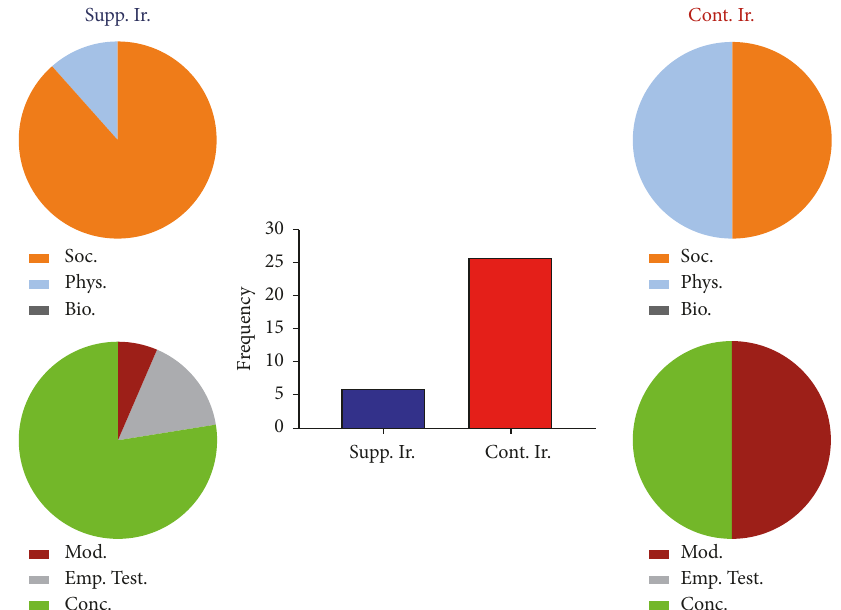
Figure 3: Visualising the frequency of quotes on the term irrationality that convey support for the theory versus those that challenge it. The pie charts on the left show the frequency of the supporting comments across the disciplines (on the top) and across the study types (in the bottom). Similarly, the pie charts on the right show the frequency of the contradicting comments again across the disciplines (on the top) and across the study types (in the bottom). The column chart in the middle compares the frequency of these comments in total regardless of the discipline or type of the study from which the comments were